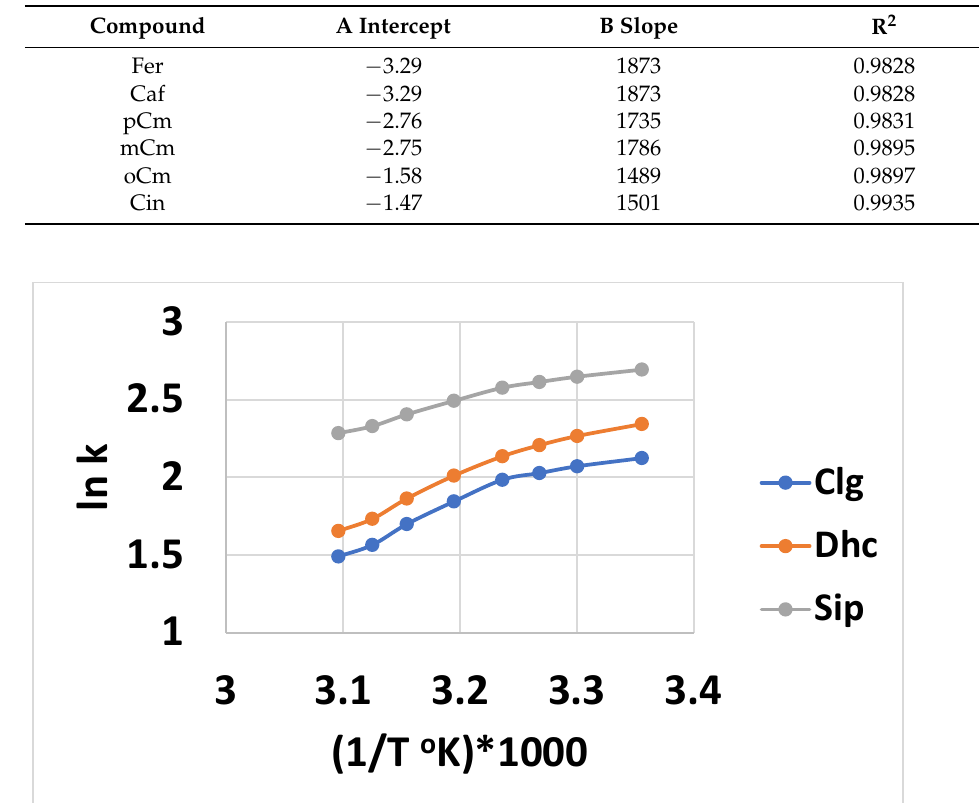
Figure 4. Plots of ln retention factor k versus (1/T °K)*1000 using data in Figure x for Clg, Dhc, and Sip. Quadratic equation data fit: Clg, y= −8.16 x 2 + 55.21x – 91.23, R 2 = 0.9944; Dhc, y = −6.40x 2 + 44.03x – 73.35, R 2 = 0.9974; Sip, y = −3.88x 2 + 26.65x – 43.08, R 2 = 0.9963.